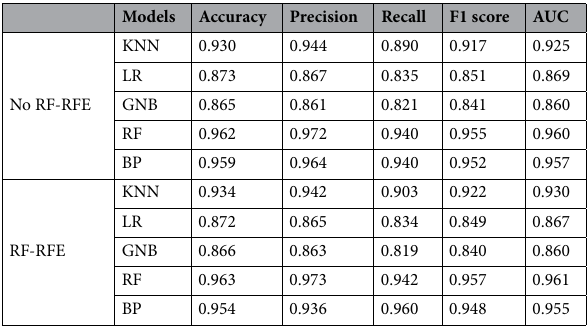
Table 3. Model evaluation results.